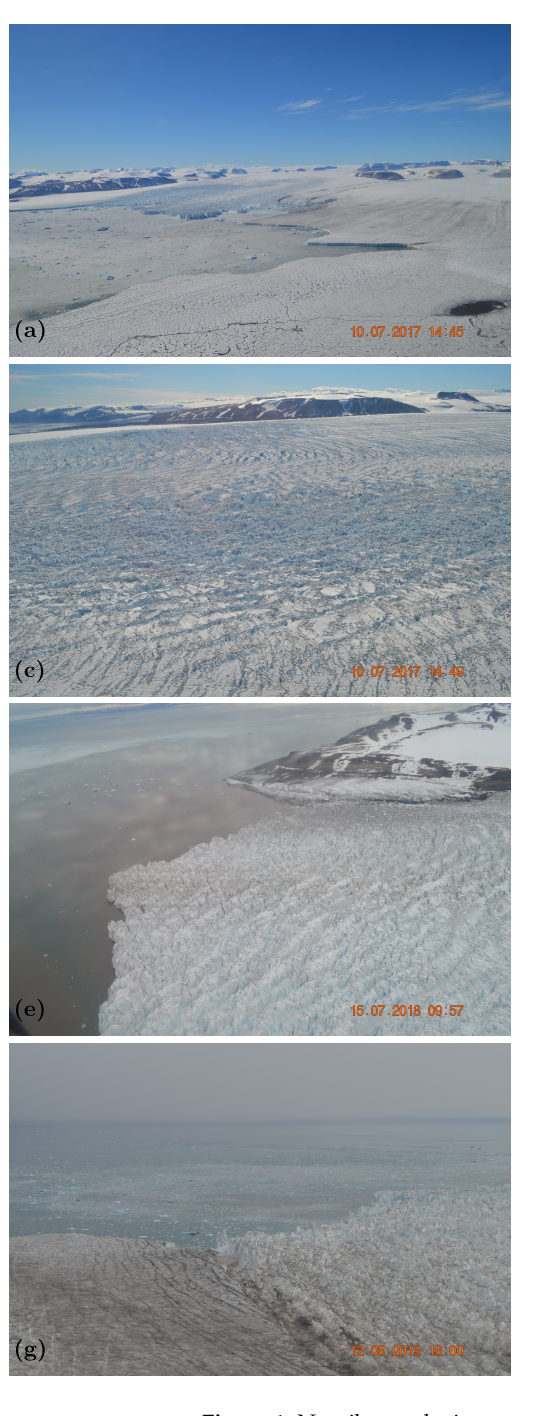
Figure 1. Negribreen during surge in 2017–2019. The multitude of different surface types indicates that a glacier during surge provides an ideal test situation for evaluation of height determination over crevassed and other complex ice surfaces. Photographs by Ute Herzfeld. ( a ) Negribreen surge July 2017, overview. ( b ) Wavy crevasses and folded moraines in central Negribreen, July 2017. ( c ) Several different crevasse provinces in central Negribreen, July 2017. ( d ) Calving front, ice fingers advancing into the ocean (front right), with smooth surface of non-surging Ordonannsbreen in the back left, July 2017. ( e ) Crevasse province near calving front July 2018. ( f ) Blocky crevasses near RGT 594 region, July 2018. ( g ) Ordonannsbreen-Negribreen boundary near calving front, August 2019. ( h ) Folded moraines and surge crevasses, August